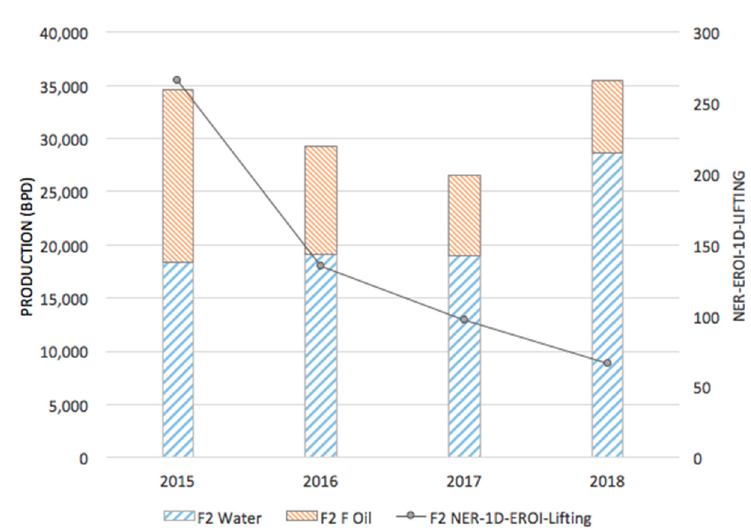
Figure 2. Field 2 Production vs. NER-1d-EROI Lifting.